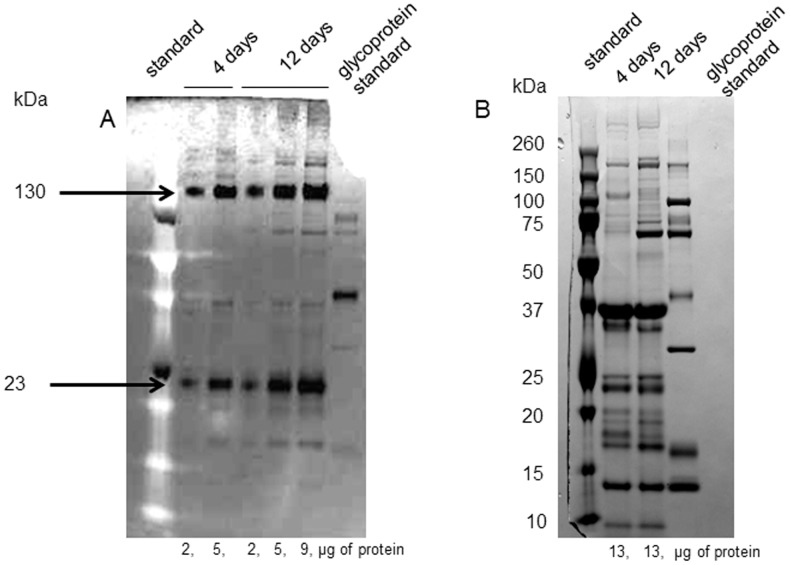
Representative samples of the glycosylation determination.The gel contains saliva samples from a single rat after 4 or 12 days exposure to the tannic acid diet. The samples were loaded in duplicate on the same12% SDS/PAGE. The quantity of protein loaded in each lane was varied to allow for maximal visibility of the protein band. After resolving the gel, it was cut into two pieces. Gel A was stained using Pro-Q Emerald 300 glycoprotein detection kit, which detects only glycosylated proteins. Gel B was stained with Coomassie R250 stain, which detects total proteins. Both gels contain both Candy-Cane glycoprotein molecular weight standards and Bio-Rad molecular weight standards.